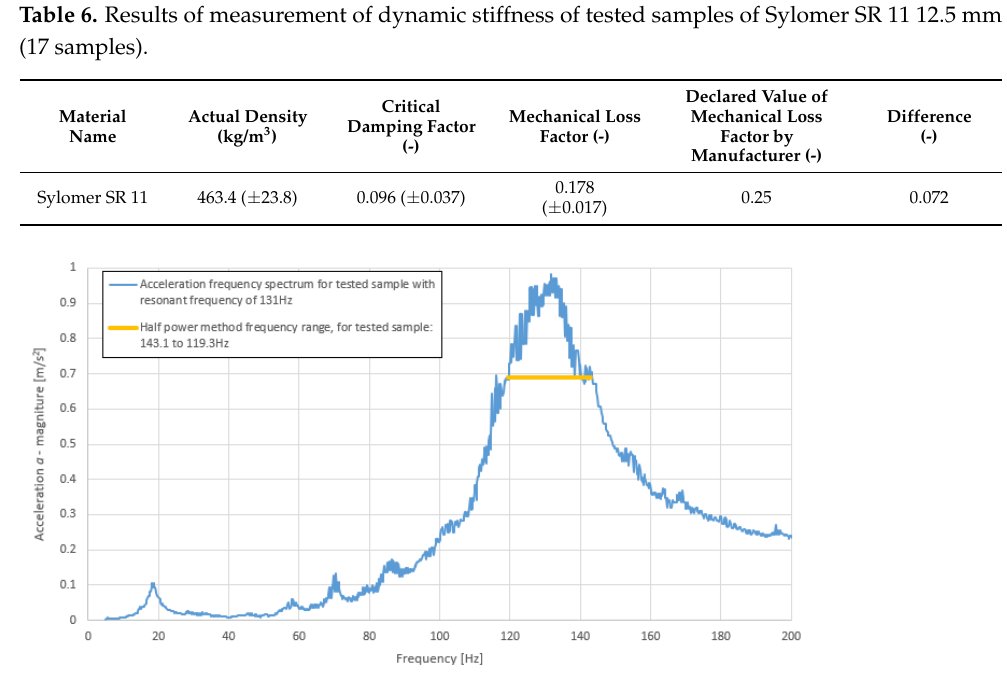
Figure 12. Acceleration frequency response spectrum of an example sample of Sylomer SR 11 12.5 mm polyurethane with indication of half-power frequency range (D = 9%) (own elaboration).